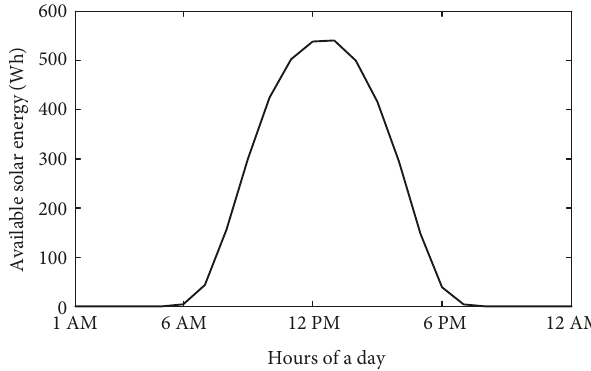
Figure 2: Average hourly solar energy